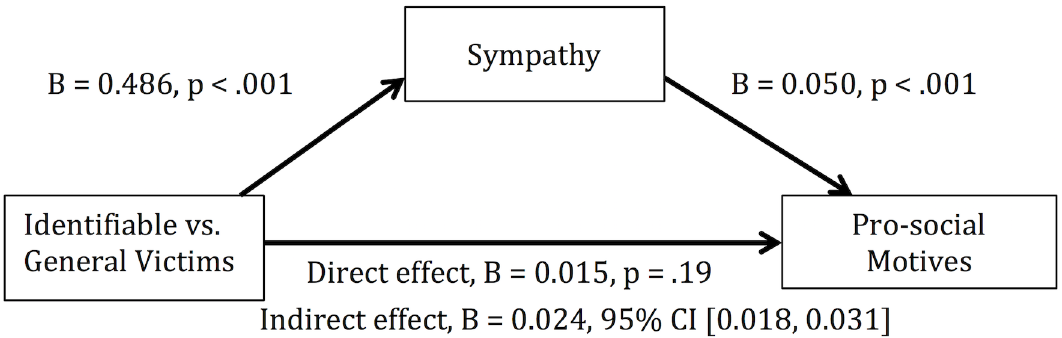
Fig 2. Mediational Model for the effect of identifiable victim on prosocial motives, mediated by sympathy. This mediation was based on the bootstrapping method for calculating indirect effect. Analysis was performed in SPSS using the PROCESS macro developed by Hayes [ 32], with 5000 resampling to compute the Bias Corrected boot strapped 95% Confidence Intervals (BCa CI). Total effect of identifiable victim on prosocial motive was significant, B = 0.039, BCa 95% CI [0.017, 0.061], p =